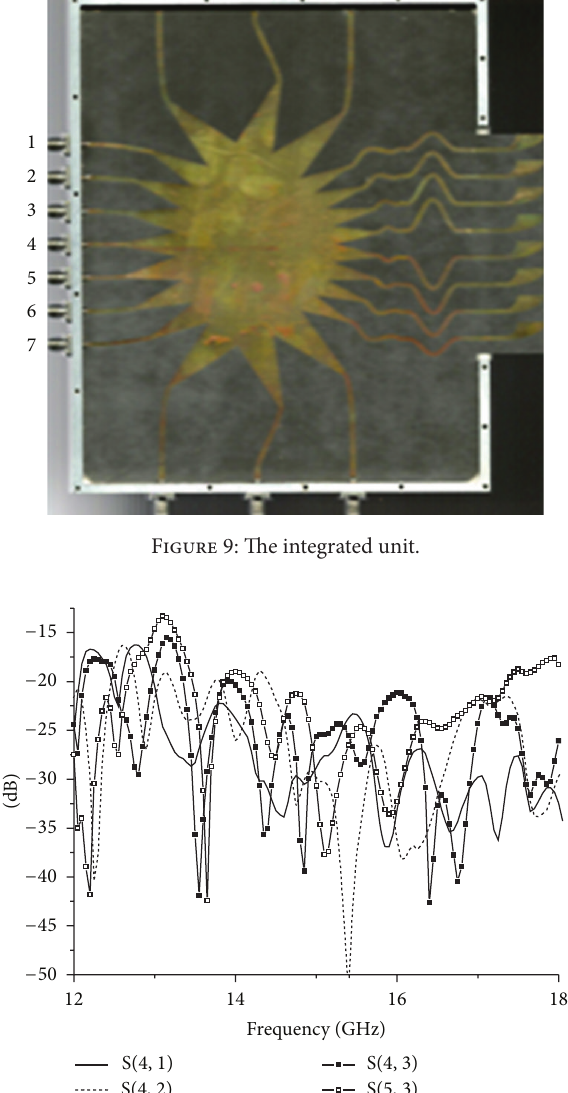
Figure 12: Multibeam pattern of the integrated unit at